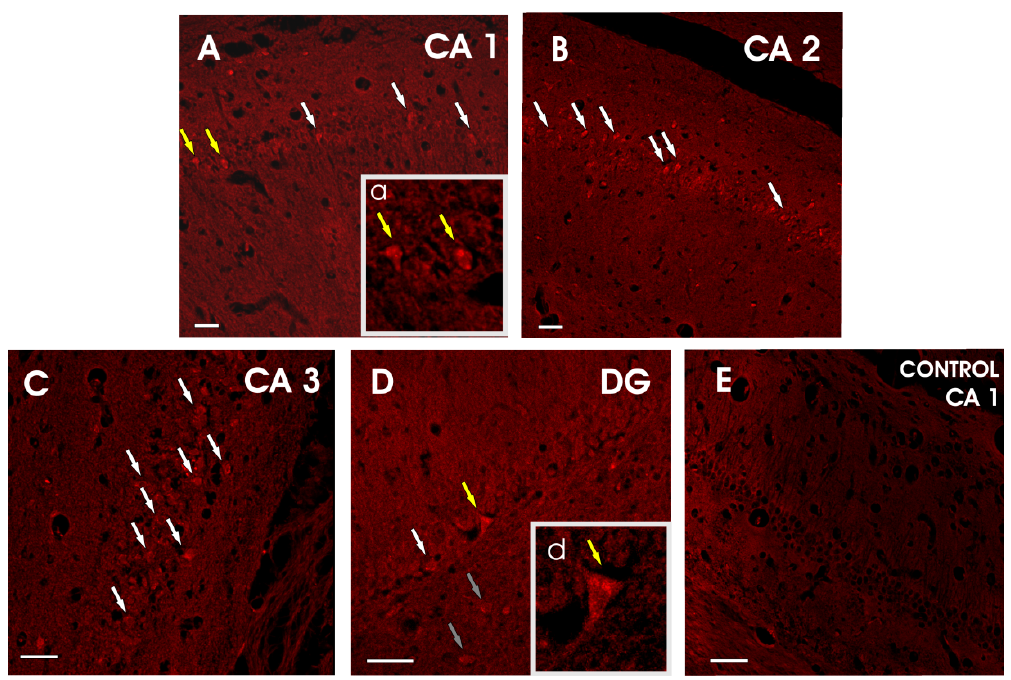
Figure 14. Photomicrographs illustrating the uptake of PLGA 65/35-HPC–GAL–Rhod nanoparticles by neurons of all layers of the entire hippocampal formation at 48 h after their intranasal (IN) delivery. Administered nanoparticles were found intra-neuronally in the pyramidal neurons of the CA1 (white and yellow arrows) ( A ), CA2 (white arrows) ( B ), and CA3 (white arrows) ( C ) fields and also in the mossy cells (grey arrows) ( D ) and granule cells of the DG (white and yellow arrows) ( D ). PLGA 65/35–HPC–GAL–Rhod nanoparticles formed aggregates that were distributed in the cytoplasm of hippocampal neurons (yellow arrows, a and d). No fluorescence was seen in hippocampal sections of the IN saline-treated rats ( E ). Scale bar = 50 μ m.